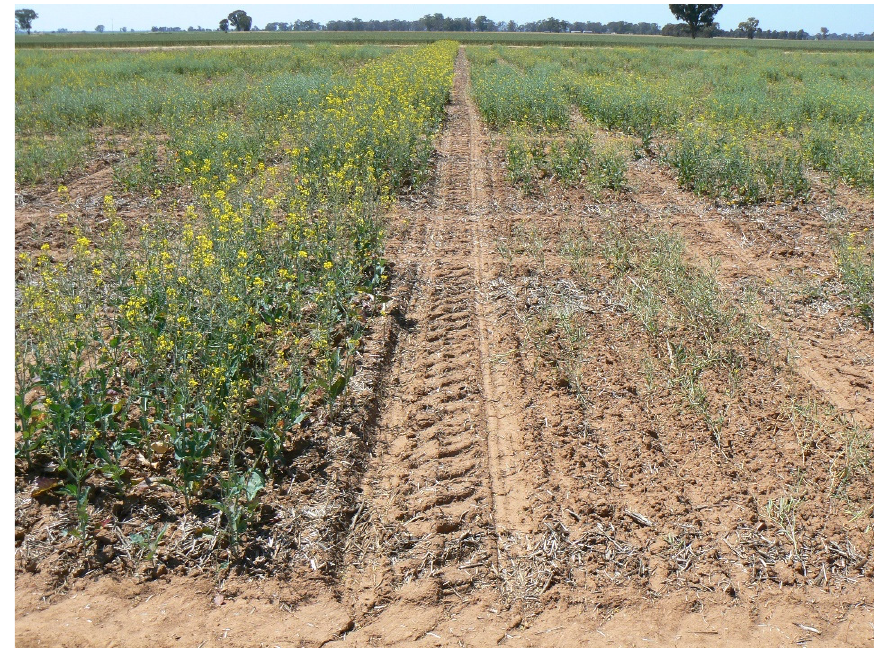
Figure 3. Impact of blackleg (Phoma stem canker) disease in the disease nursery field trial 2016AU2 at the late flowering stage. The 4-m × 1.8-m plot on the left was intermediate in resistance (BL score 5) and the plot on the right was very susceptible (BL score 1).